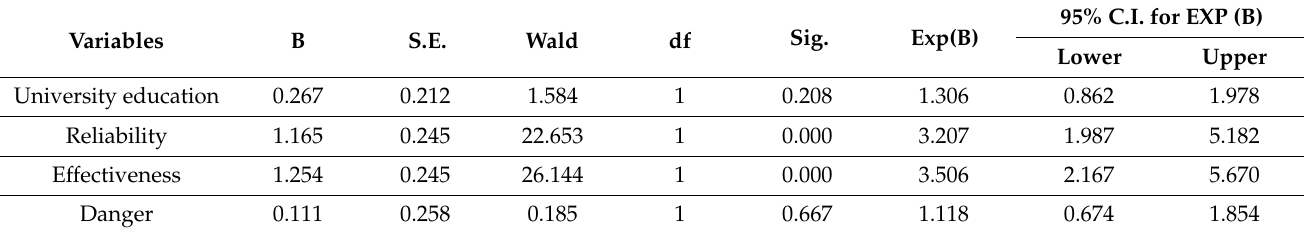
Table 5. Logistic regression with a volition to go to the hospital ED if needed as a dependent variable.